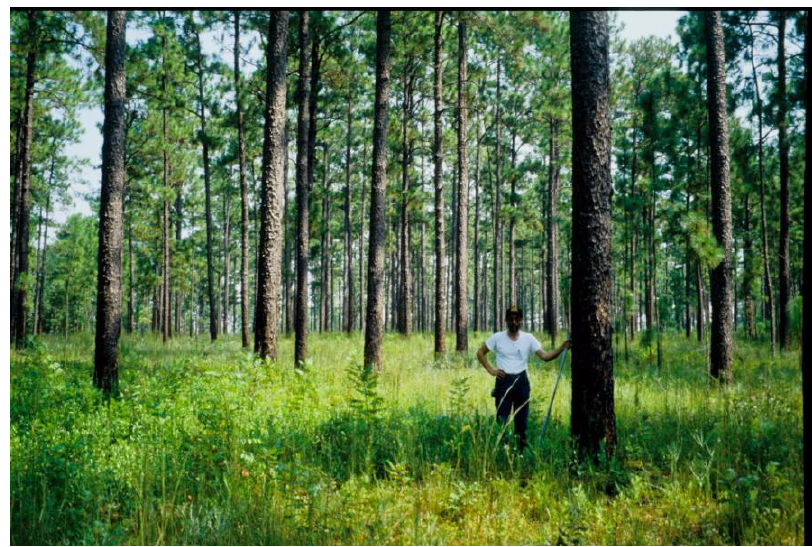
Figure 4. Restored longleaf pine Savanna ecosystem in Alabama (photograph by Dale Brockway, USDA Forest Service).